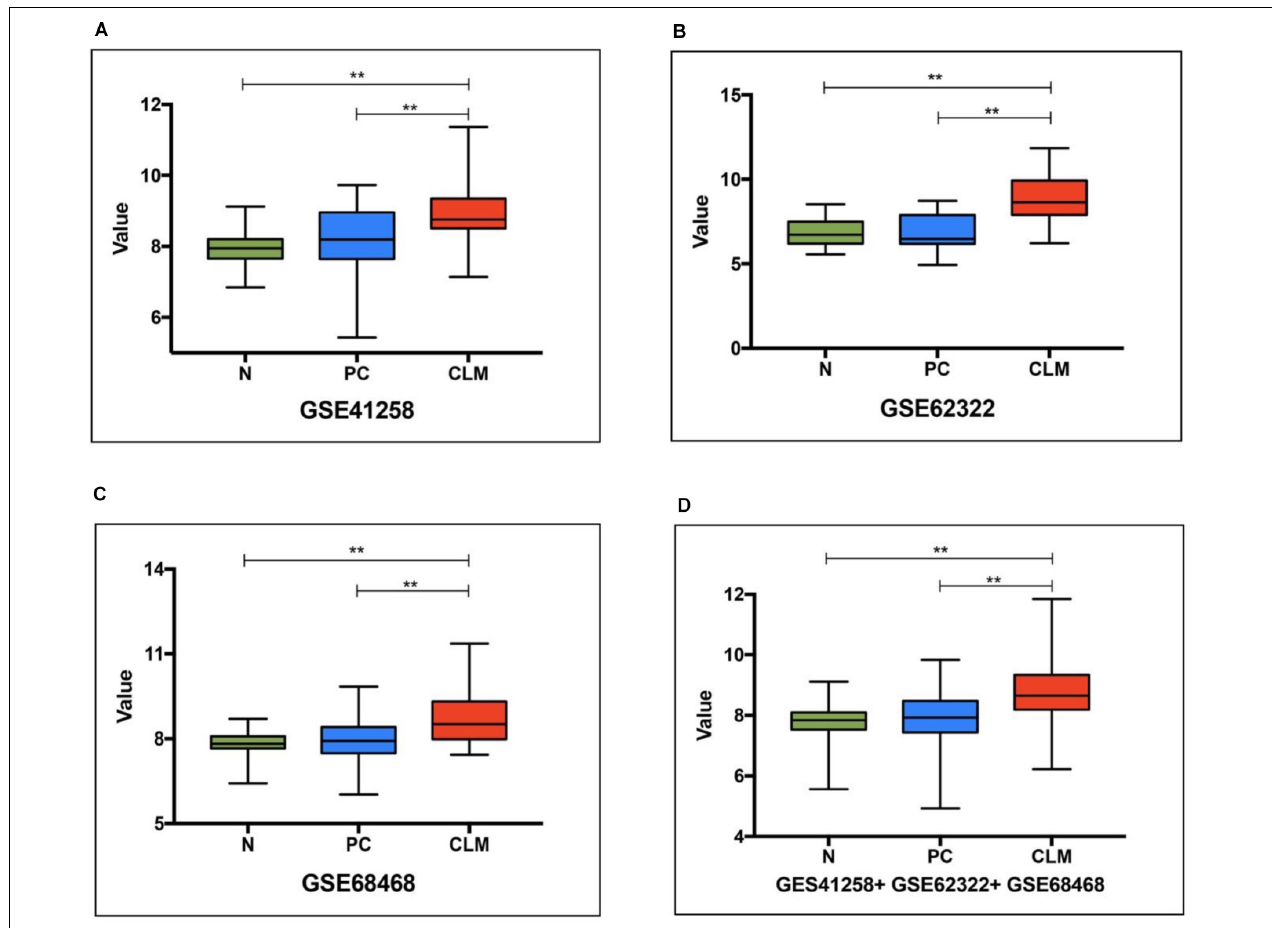
FIGURE 2 | ApoE expression pattern in the normal intestinal mucosa, primary tumor and colorectal liver metastasis based on 3 datasets ( A , GSE41258, B , GSE62322, C , GSE68468) from GEO and their pooling set (D) . N, normal intestinal mucosa; PC, primary colorectal cancer; CLM, colorectal liver metastasis; ∗∗ Represents p -value <